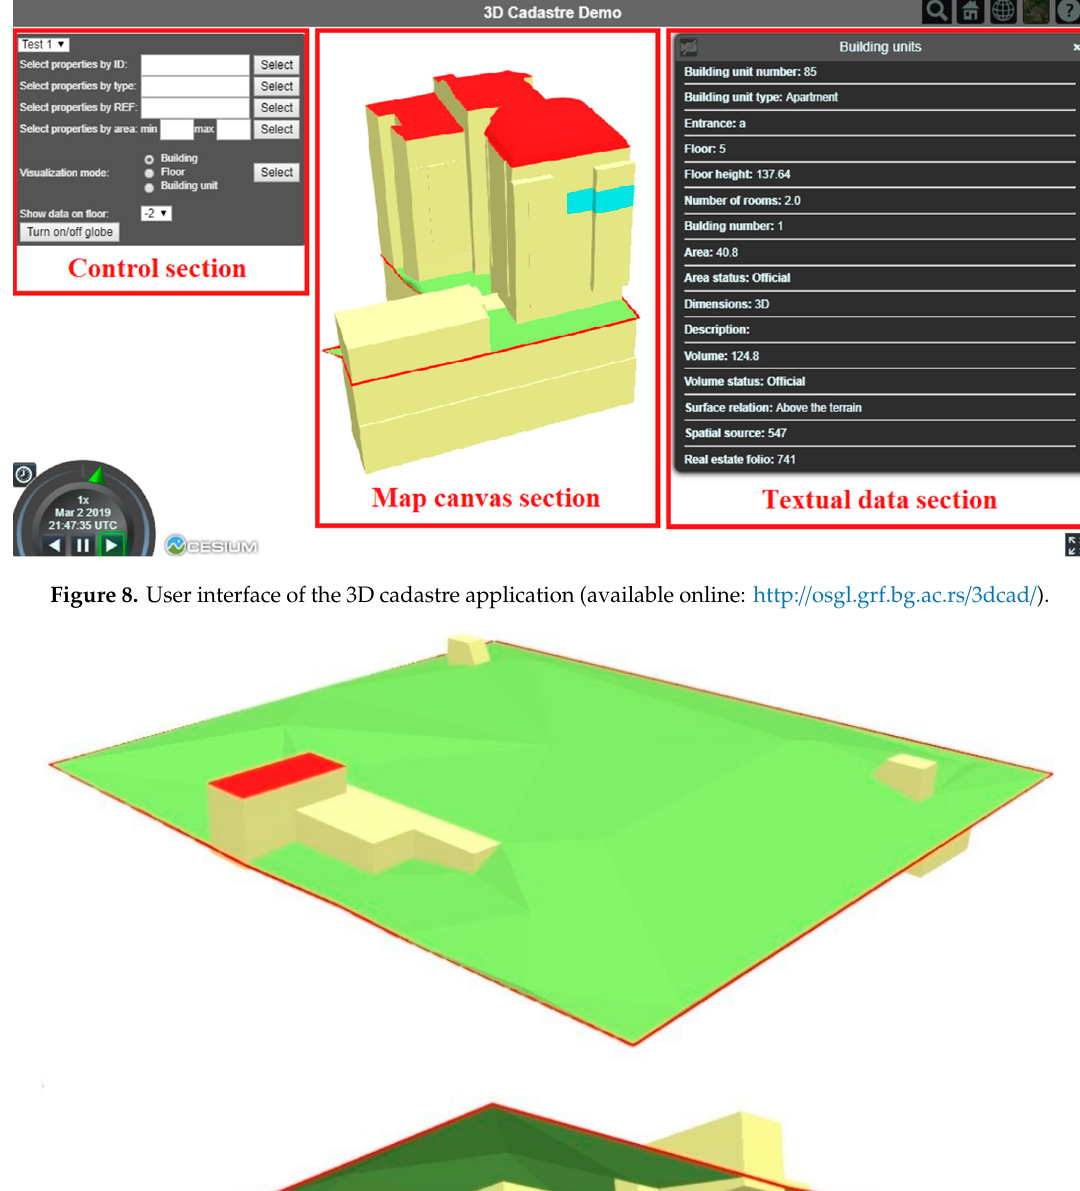
Figure 10. Visualization by using the floor mode.